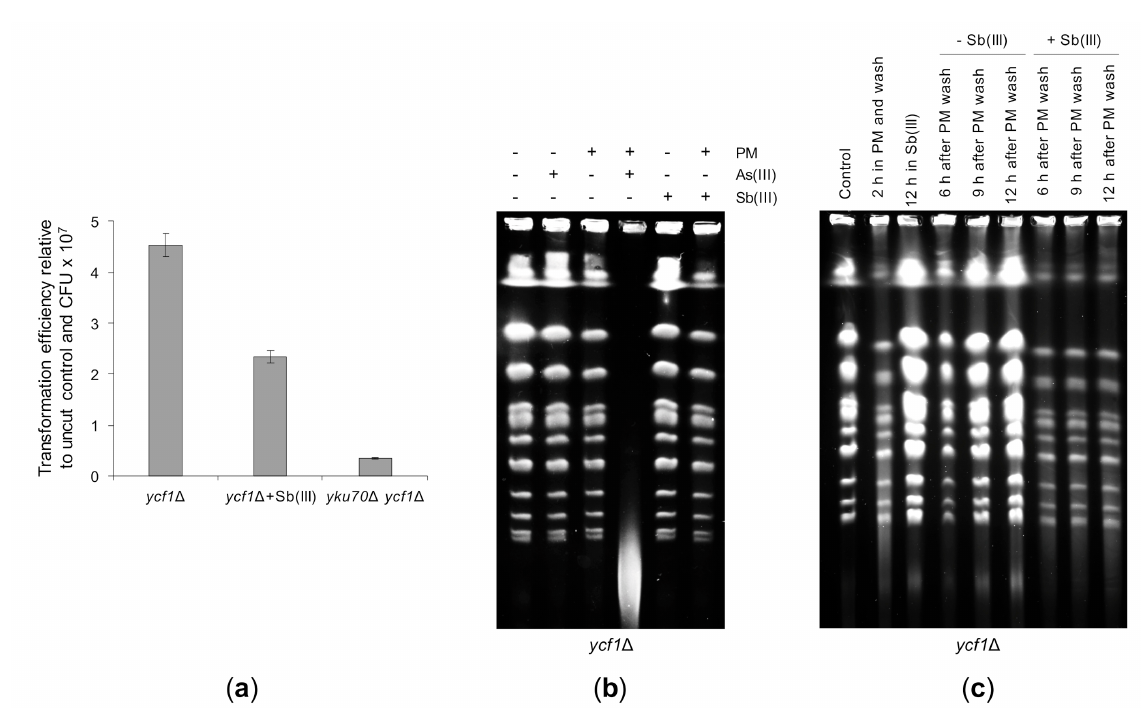
Figure 10. The repair of DBSs is negatively affected by Sb(III). ( a ) Sb(III) decreases the ability of yeast cells to repair cohesive DSBs by NHEJ. Indicated strains were transformed in parallel with Pst I-cleaved YCplac111 and supercoiled YCplac111. In addition, ycf1 ∆ cells were exposed to 0.2 mM Sb(III) for two hours, washed and used for transformation with the same set of plasmids. Transformation efficiency was expressed as the ratio of colonies obtained with the linear plasmid divided by colonies obtained with the uncut plasmid normalized to the number of viable cells used for transformation. Each bar represents the mean of four independent experiments with SD. ( b ) Sb(III) does not enhance genotoxicity of phleomycin (PM). The ycf1 ∆ mutant was exposed to 10 µ g/mL PM, 5 mM As(III) or 5 mM Sb(III) for 6 h followed by isolation of genomic DNA and PGFE analysis. ( c ) Sb(III) inhibits the repair of PM-induced DSBs. The ycf1 ∆ mutant was exposed to 35 µ g/mL PM for 2 h, washed and released in the presence or absence of 0.2 mM Sb(III) for up to 12 h. Cells were also left untreated or cultivated in the presence of 0.2 mM Sb(III) for 12 h. At indicated time-points, genomic DNA was prepared and analyzed by